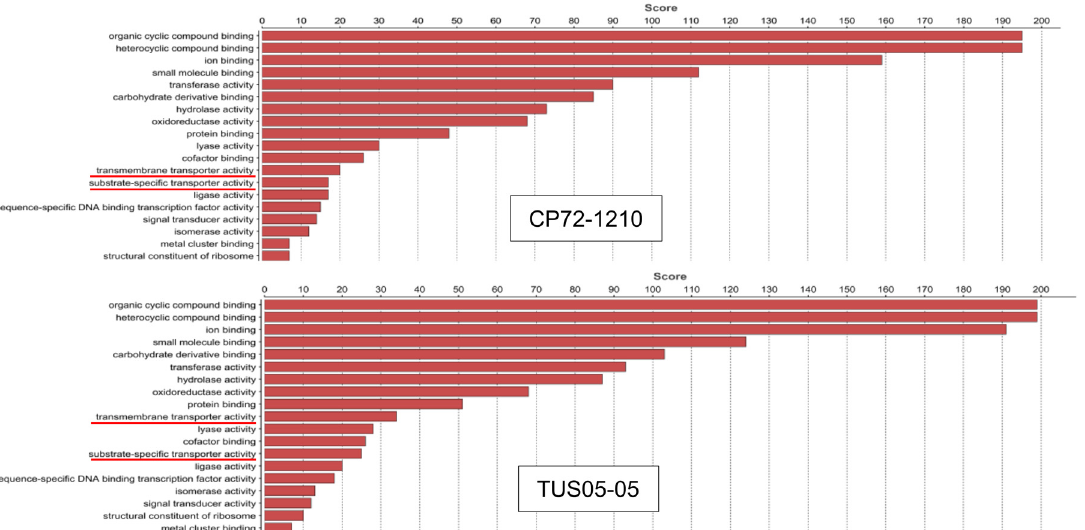
Fig 2. Analysis of gene annotation of differentially expressed genes after chilling stress. The annotated sequences of CP72-1210 (top) and TUS05-05 (bottom) were analyzed based on the molecular function of GO terms by Blast2Go. GO terms are listed on the left, and the Blast2Go score of molecular function at level 3 is shown on top. The molecular function of transmembrane transporter activities are underlined in red.